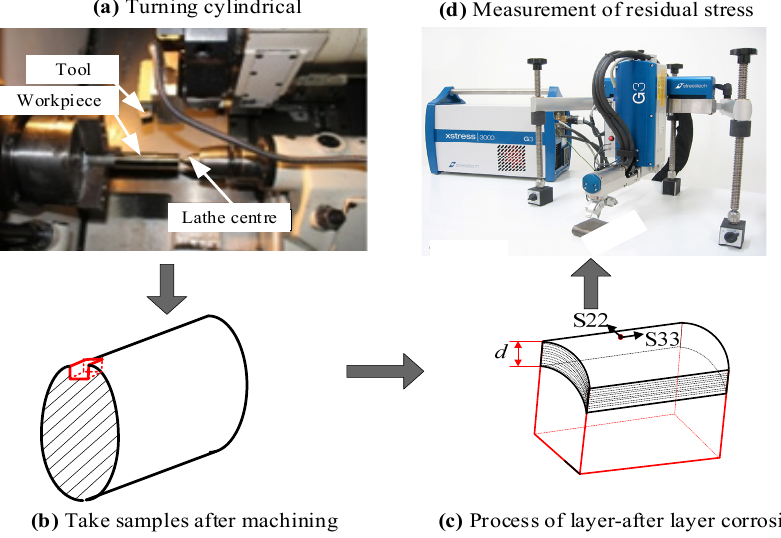
Figure 4. Procedure for residual stresses measurement.